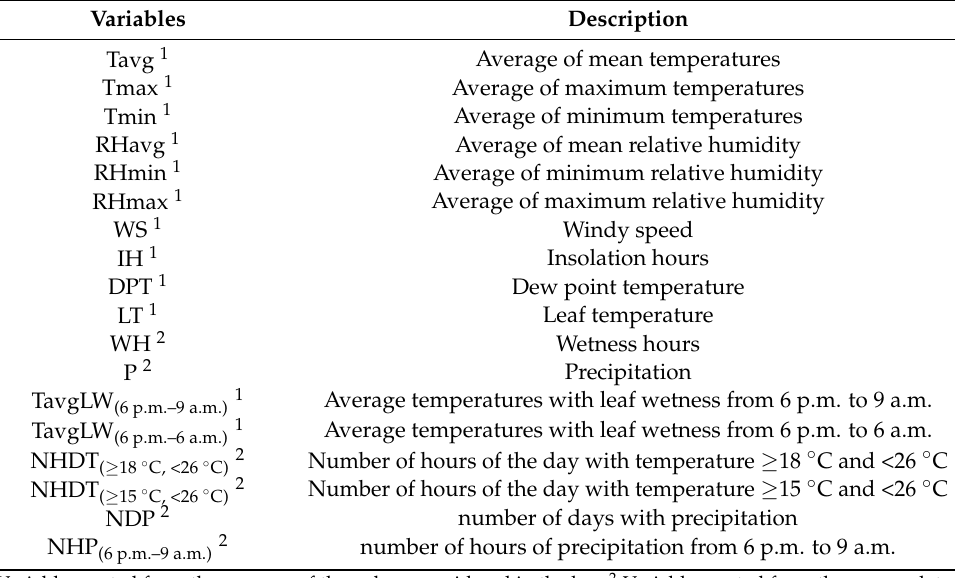
Table 3. Environmental variables collected and generated with an automatic station model Davis Vantage Pro ® , software Weather Link ® , located in the five cities or nuclei of the Cooperative of Coffee Growers of Guaxup é (Cooxup é